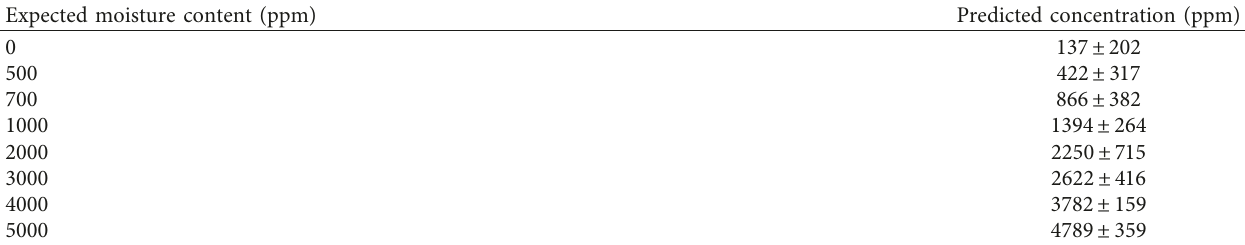
Table 6: Self-prediction of the calibration samples (transformer oil).